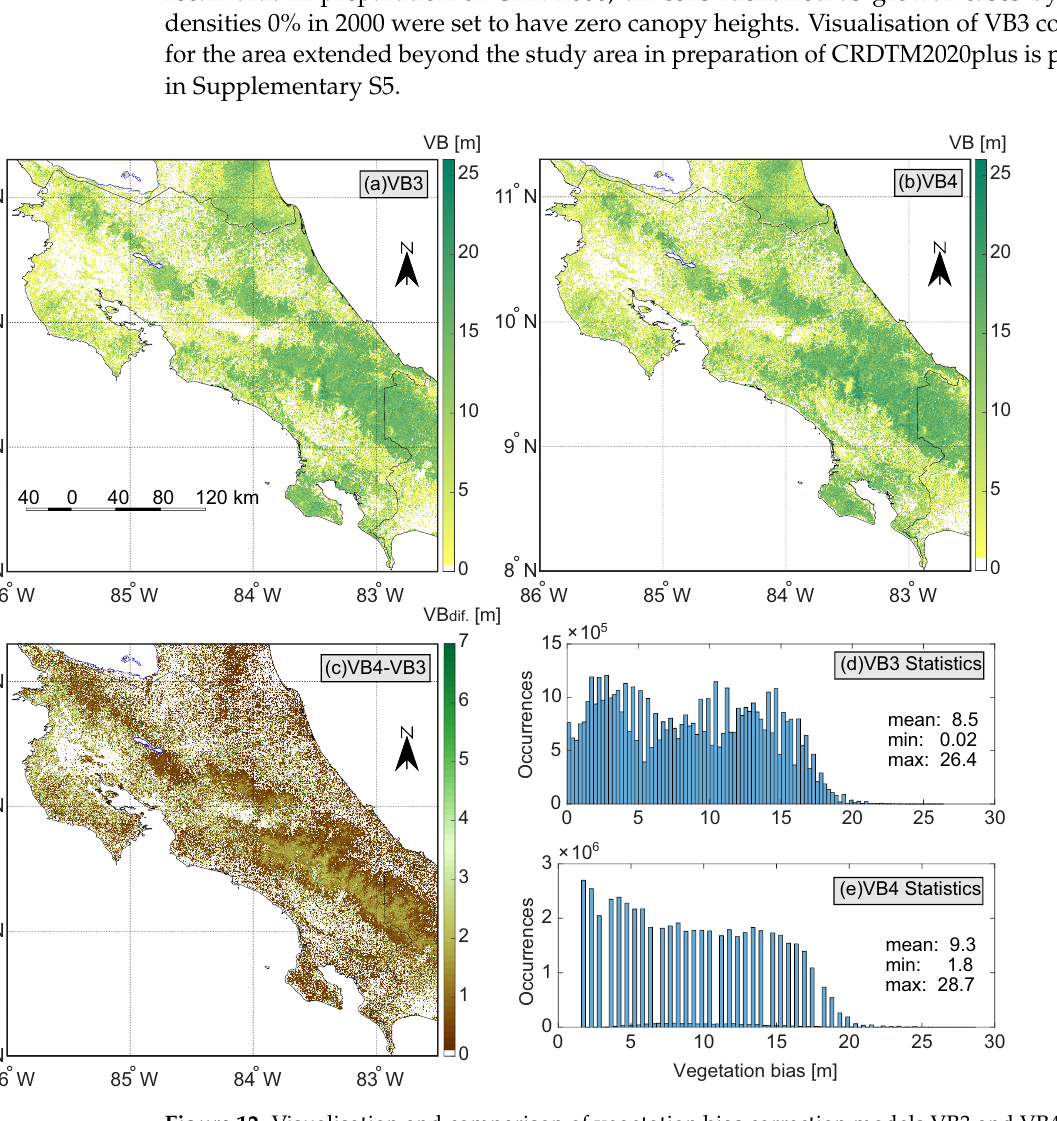
Figure 12. Visualisation and comparison of vegetation bias correction models VB3 and VB4. ( a ) VB3. ( b ) VB4. ( c ) VB4-VB3. ( d ) VB3 histogram and statistics. ( e ) VB4 histogram and